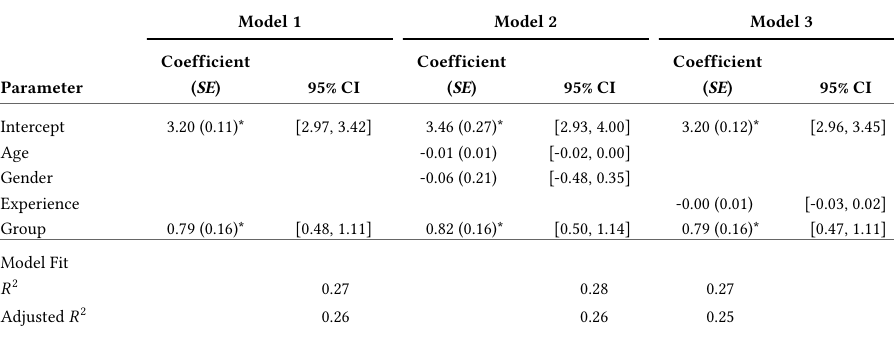
Linear Regression Models Predicting Listening Skills